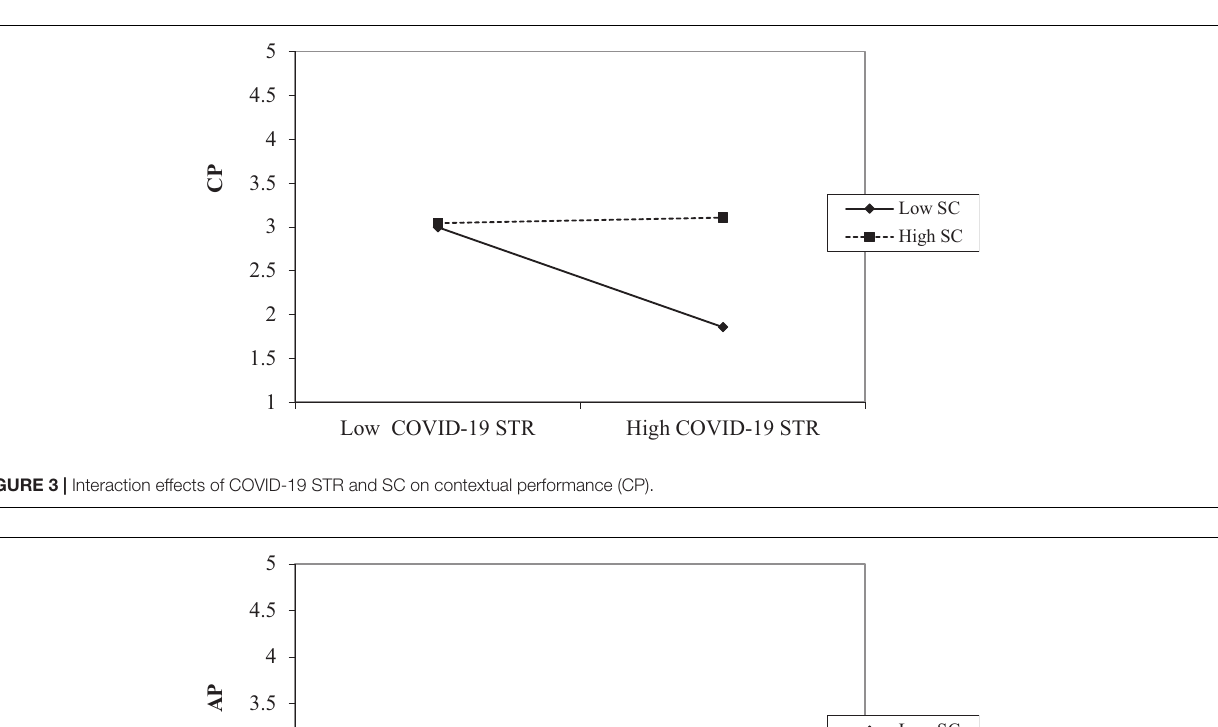
FIGURE 2 | Interaction effects of stress due to COVID-19 (COVID-19 STR) and safety culture (SC) on task performance (TP).